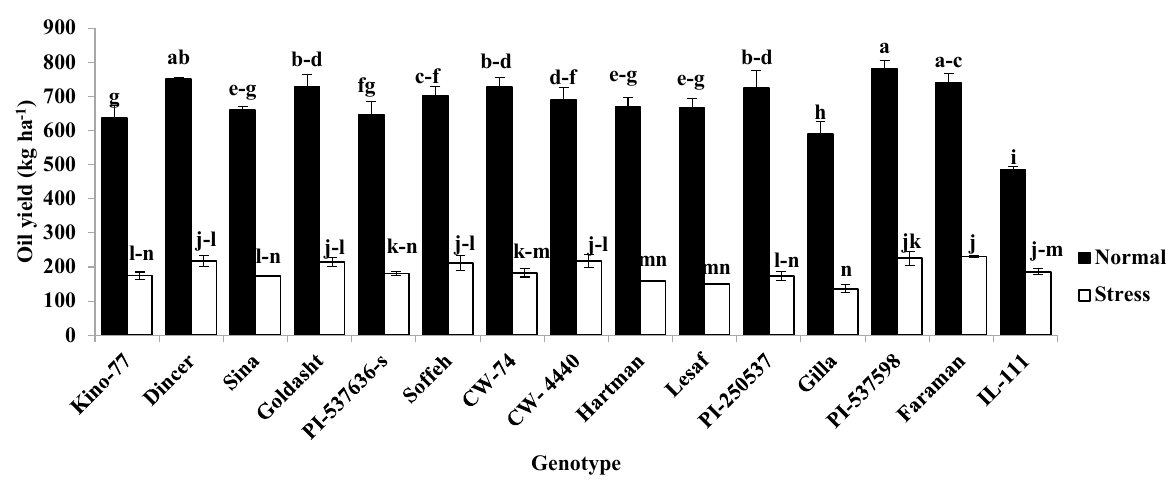
Fig. 6 Interaction effect of irrigation and genotype on oil yield. Mean values with the same letters are not significantly different ( p > 0.05) according to the Duncan test. Data are presented as mean ± SEM